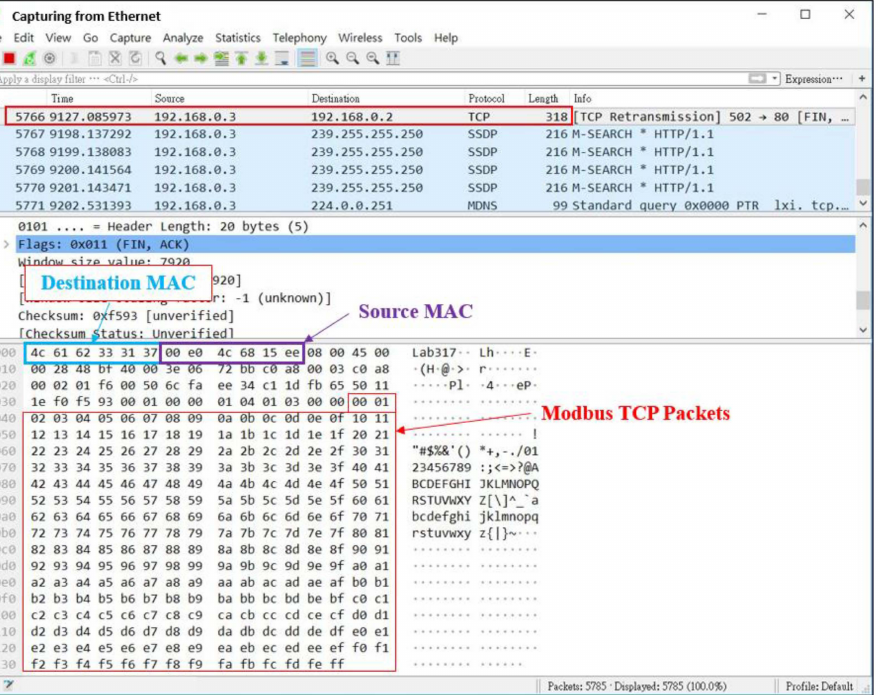
Figure 16. Transmitted Modbus TCP packets from PC2 to the FPGA development kit.